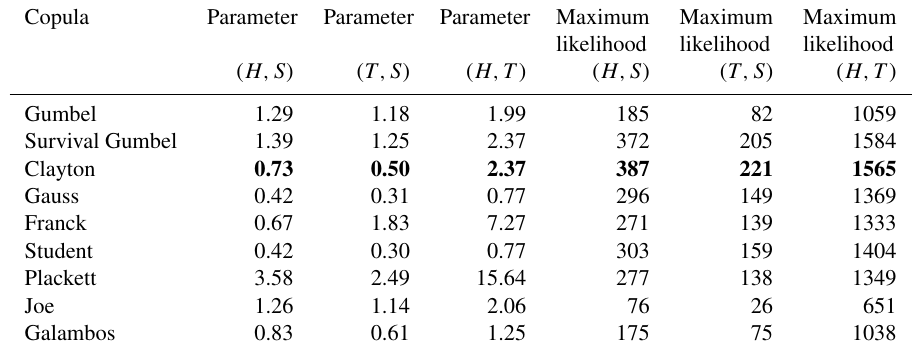
Table 5. Log-likelihood and copula parameter for the different bivariate copulas between the parameters H and S , T and S , and H and T . Copula Parameter Parameter Parameter Maximum